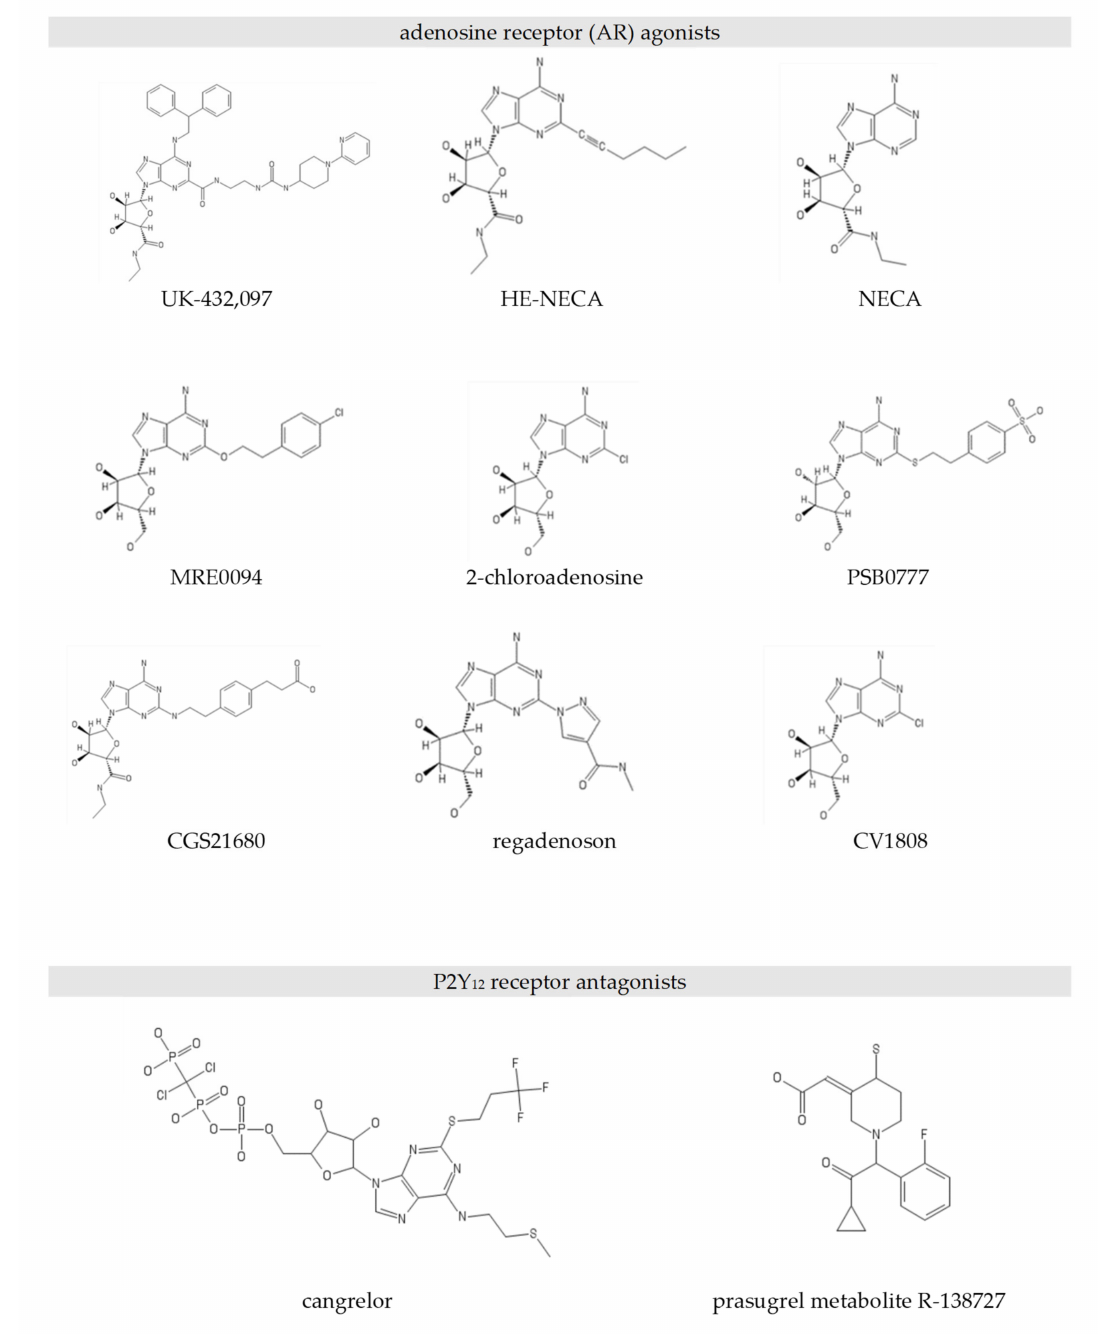
Figure 1. Chemical structures of selected adenosine receptor agonists and P2Y 12